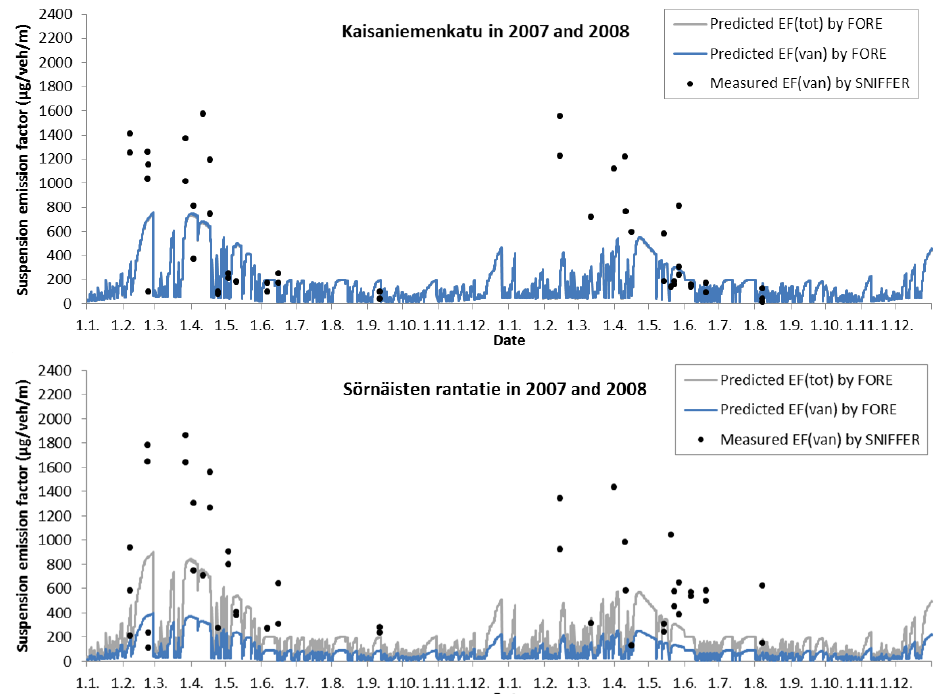
Figure 3. Hourly average suspension emission factors for all traffic (EF tot ) and for a van (EF van ) , predicted using the FORE model and measured in Kaisaniemenkatu (upper panel) and Sörnäisten rantatie (lower panel) in 2007 and 2008. In the lower panel, the ratio of predicted EF tot and predicted EF van is about 0.99; the predicted lines therefore overlap. Table 2. The statistical analysis of the agreement of hourly average suspension emission factors for all traffic (EF tot ) and for a van (EF van ) , predicted by the FORE model and measured in Kaisaniemenkatu and Sörnäisten rantatie in 2007–2008. Kaisaniemenkatu Sörnäisten rantatie EF tot EF van EF tot EF van Index of agreement